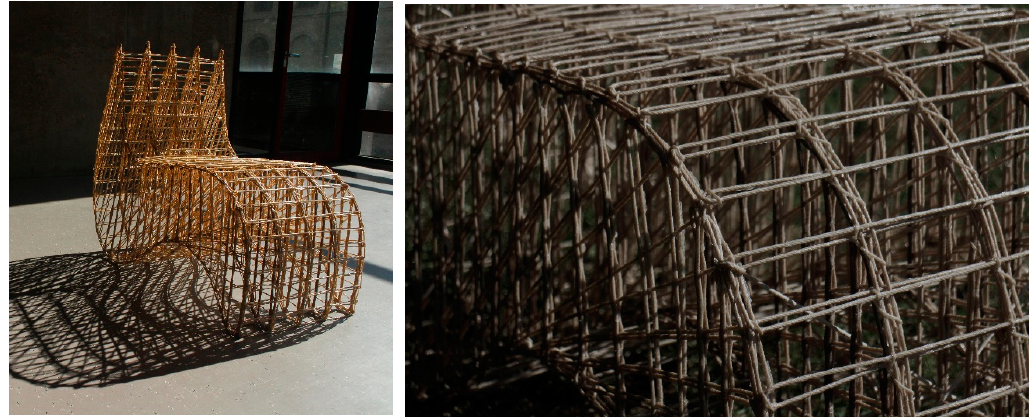
Figure 9. The final hemp chair with a closer illustration of the detailing of the connection. Photo credit: Sachin and Kauffmann, BioMat-ITKE/University of Stuttgart.